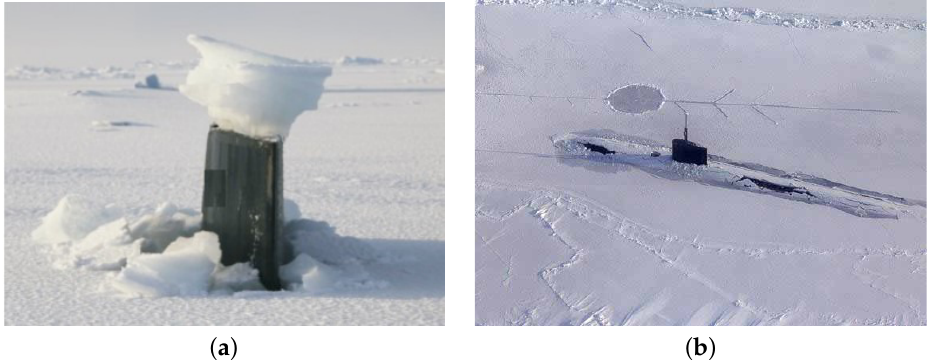
Figure 1. Photographic view of submarine floating ice-breaking. ( a ) command tower ice-breaking [23]. ( b ) hull ice-breaking